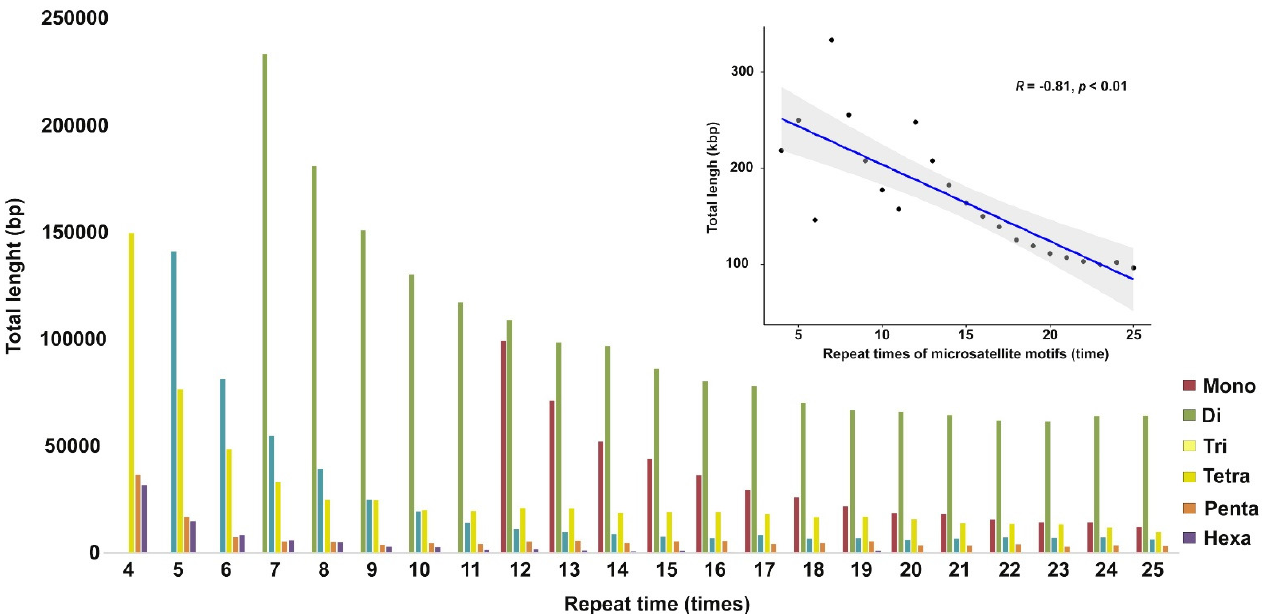
Figure 2. Scatter plots showing correlation ( R ) between the frequency of microsatellite motifs and their lengths.